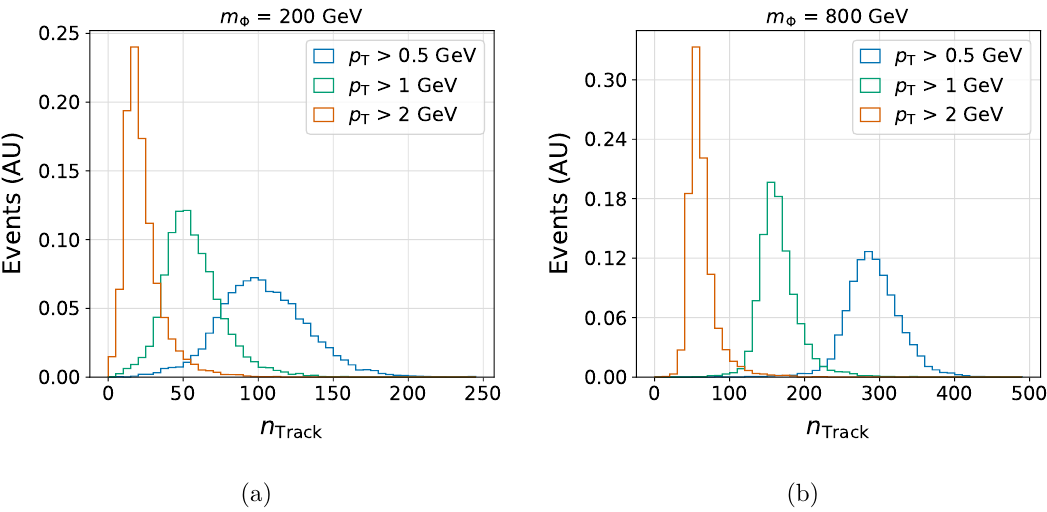
Figure 3. Number of charged particles per event which pass the specified track p T threshold, for mediators of mass 200 GeV (a) and 800 GeV